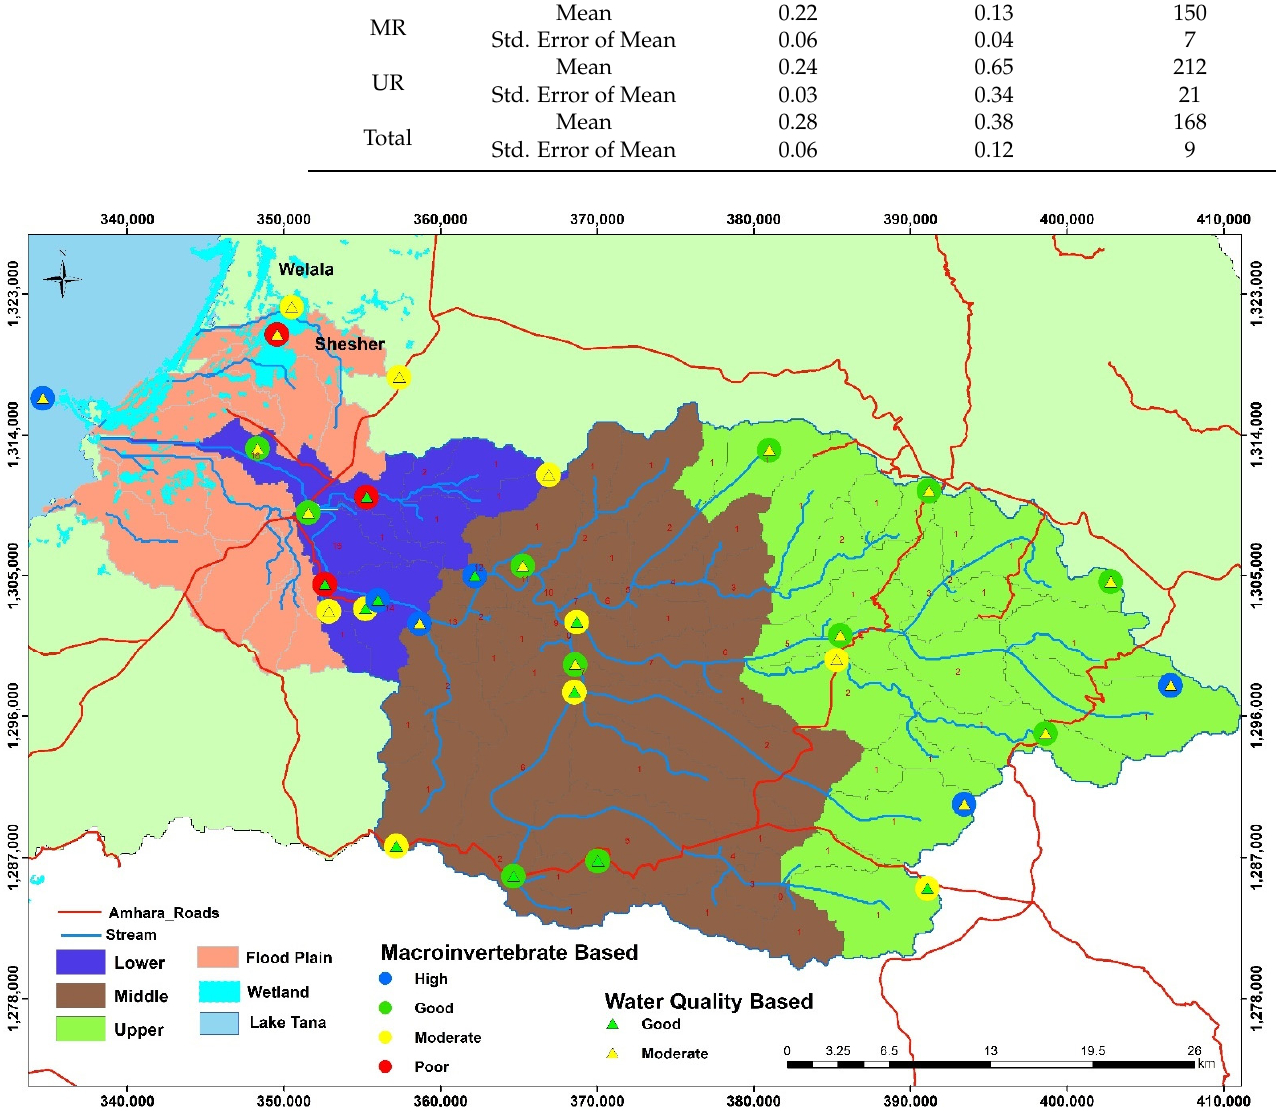
Figure 4. Water quality status in Gumara river in March 2020 based on chemical water quality requirements of fishery [26–28] and macroinvertebrate ETHBios, SASS, and BMWP